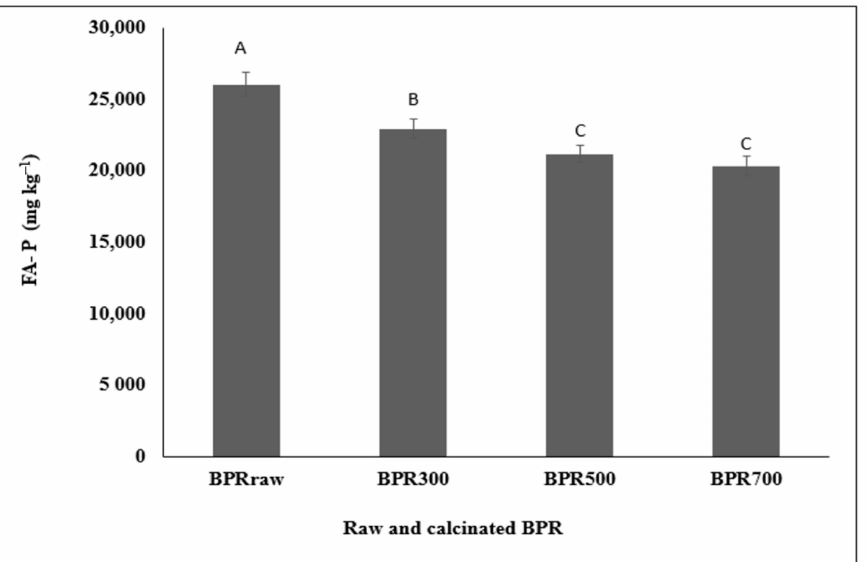
Figure 5. “Available” (i.e., formic acid-extractable) P content of raw BPR and calcinated BPR at different calcination temperatures. Error bars are standard errors. Letters on top of the error bars show significant difference at p ≤ 0.05.